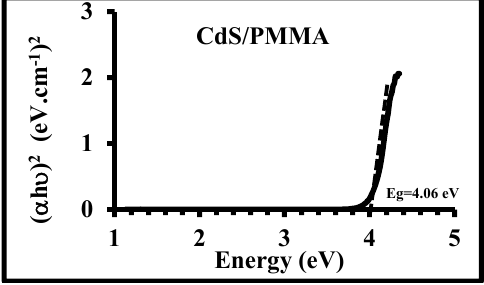
Fig. 4: Tauc plot of CdS/PMMA thin film.